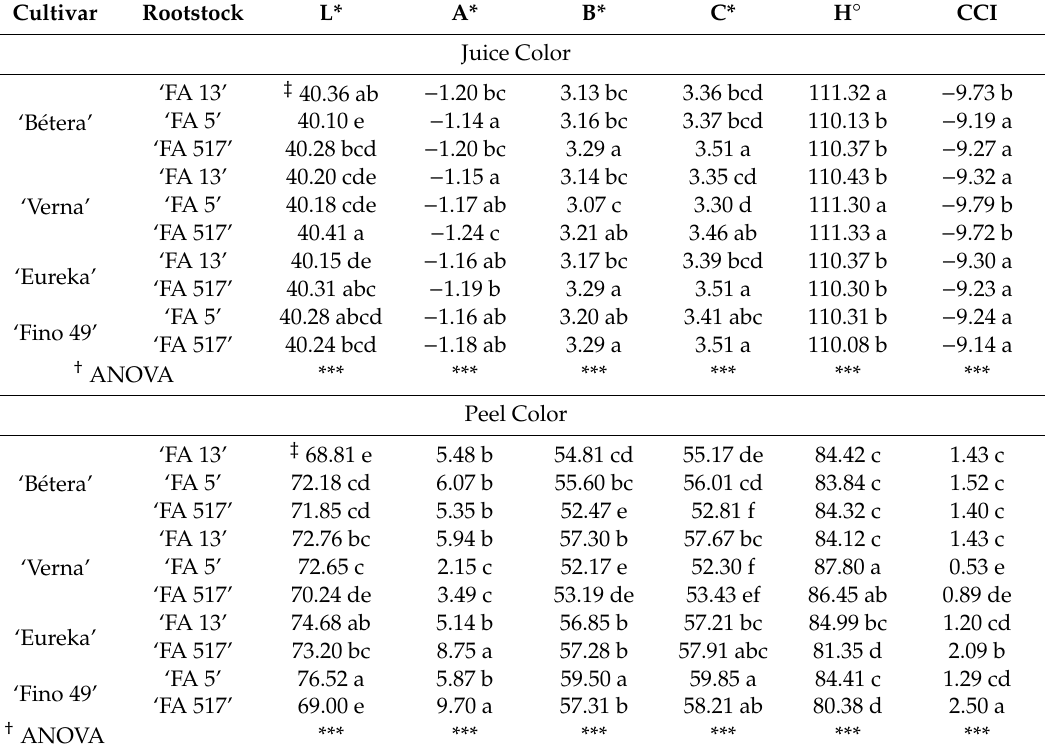
Table 2. E ff ect of di ff erent rootstocks on lemons (‘B é tera’, ‘Verna’, ‘Eureka’ and ‘Fino 49’) juice and peel, lightness (L*), red / greenness (a*), yellow / blueness (b*), chroma (C*), and hue angle (H ◦ ) values, and citrus color index (CCI = 1000 a* / L* b*).